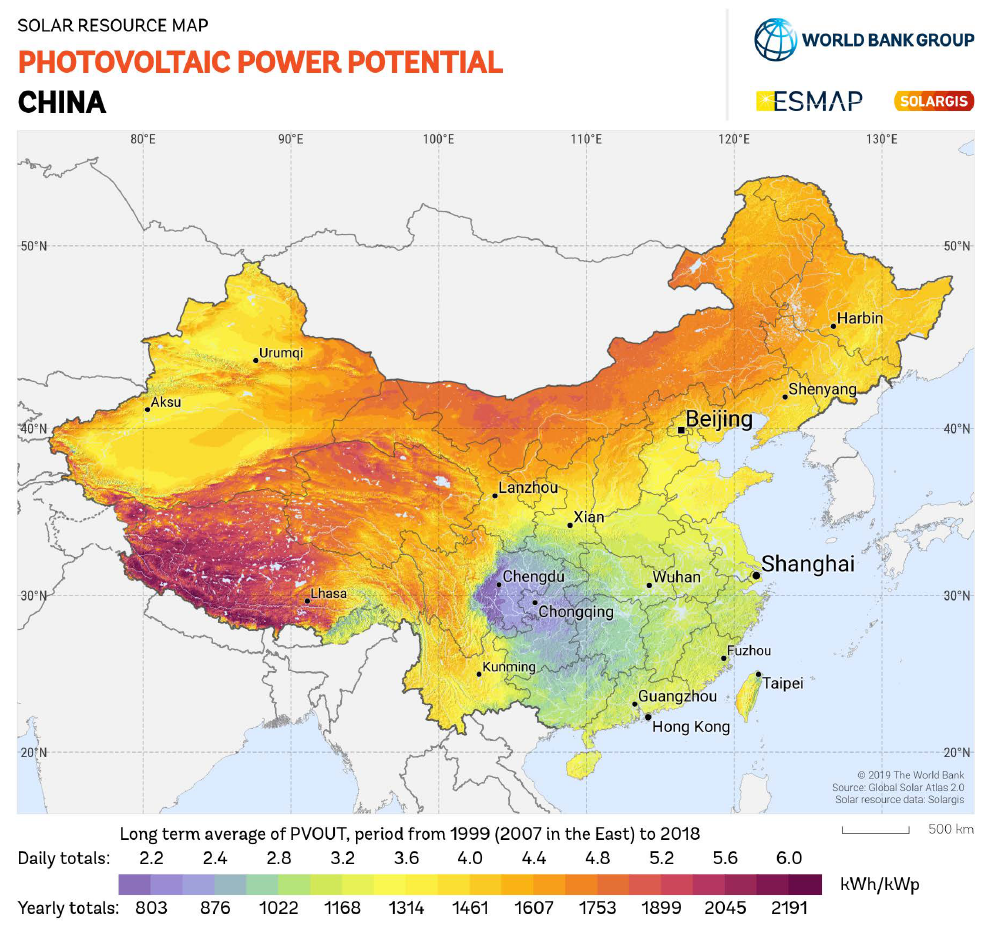
Figure 8. Solar radiation of China. Source: Global Solar Atlas 2.0, Solar Resource Data: SolarGIS. © 2019, The World